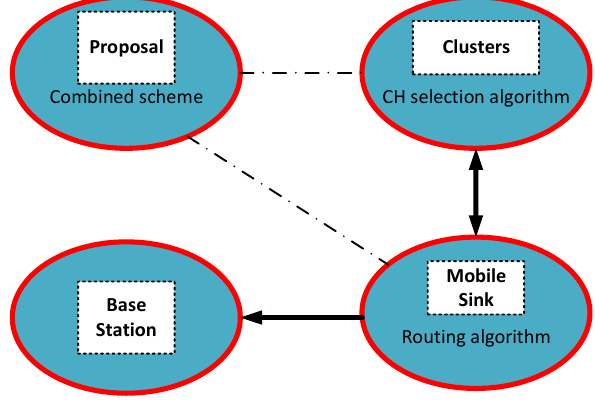
Figure 1. Our proposal design scheme.